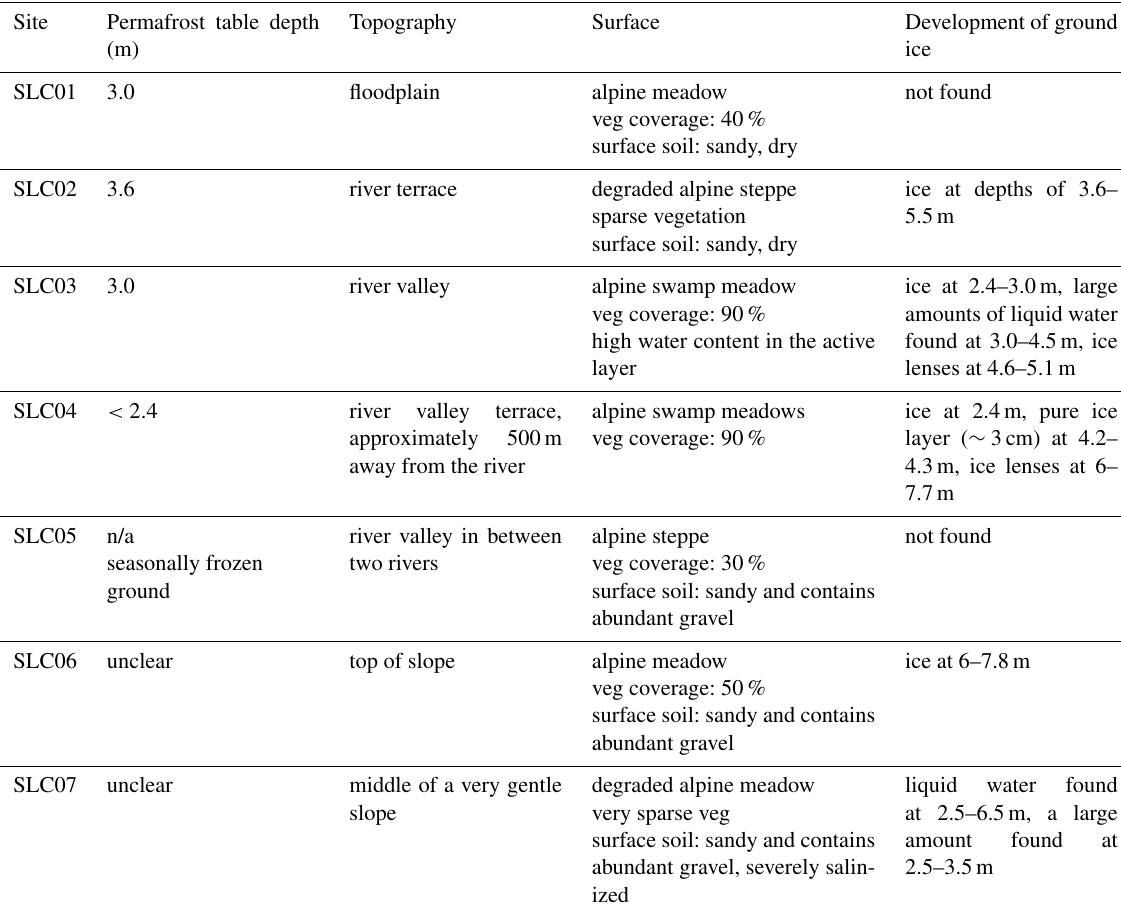
Table 2. Borehole